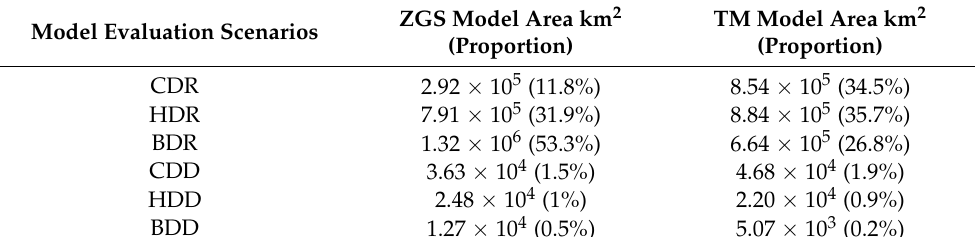
Figure 7. The Hurst index ( a ) and sustainability of the changing trend ( b ) of the ANPP in the Mongolian Plateau from 2000 to 2019. Table 2. Area and percentage of vegetation restoration and degradation under the influence of different factors, as simulated by the ZGS and TM models.